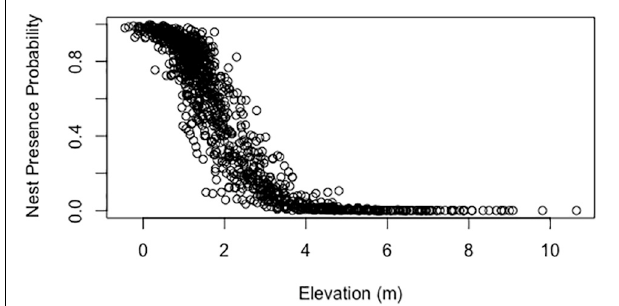
FIGURE 3 | Response curve of the predictions of model 1 in Table 3 showing the probability of nest presence versus elevation